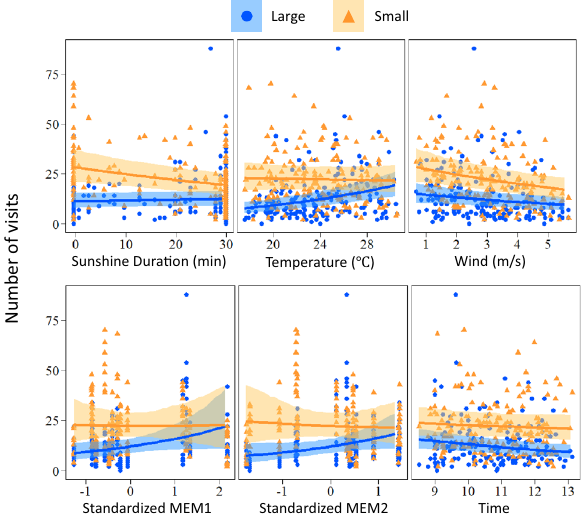
Figure 4. Relationship between weather variable or spatial variable and insect abundance for large and small insects, which was estimated by GLM. Error bands represent 95 credible intervals. Each dot represents the number of individuals observed at each census. MEM 3 and MEM 4 are not shown due to their insignificant effects. Note that MEM variables are standardized.